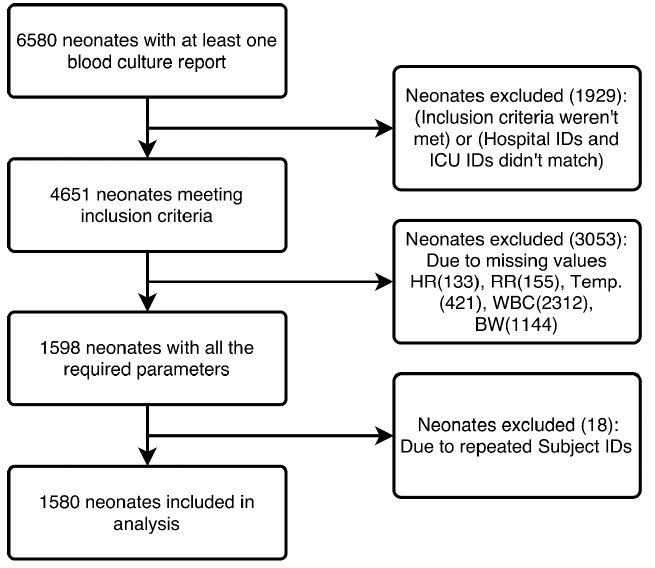
Figure 1. Study dataset generation from the Medical Information Mart for Intensive Care III (MIMIC III) database.